Question: Does the plotted quantity increase or decrease?
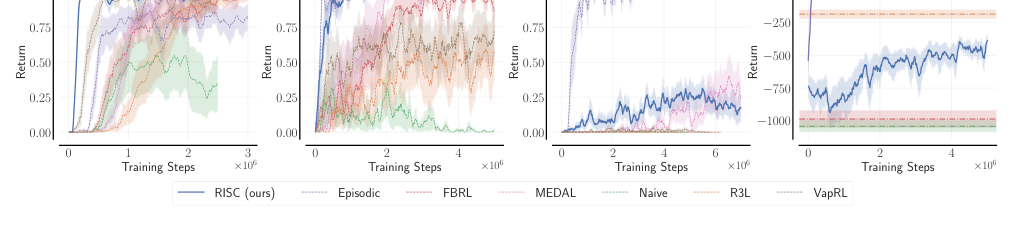
Answer: increasing